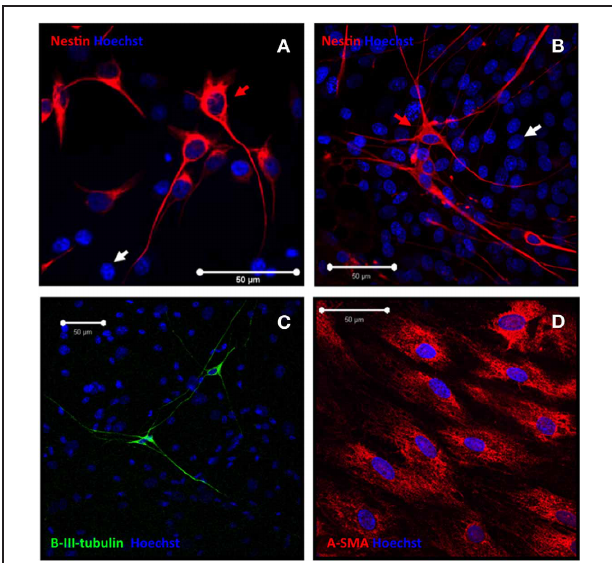
FIGURE 6 | SKPs differentiate onto seemingly immature neuronal cells. (A–B) After 10 days differentiation, SKPs differentiated into neuronal-like cells that expressed nestin (red; red arrow). Nestin negative cells (white arrow) were also present. (C) Immature neuronal phenotype was confirmed by β III-tubulin staining (green). (D) Undifferentiated stromal cells expressed α -SMA marker (red). Nuclei were counterstained with Hoechst 33258